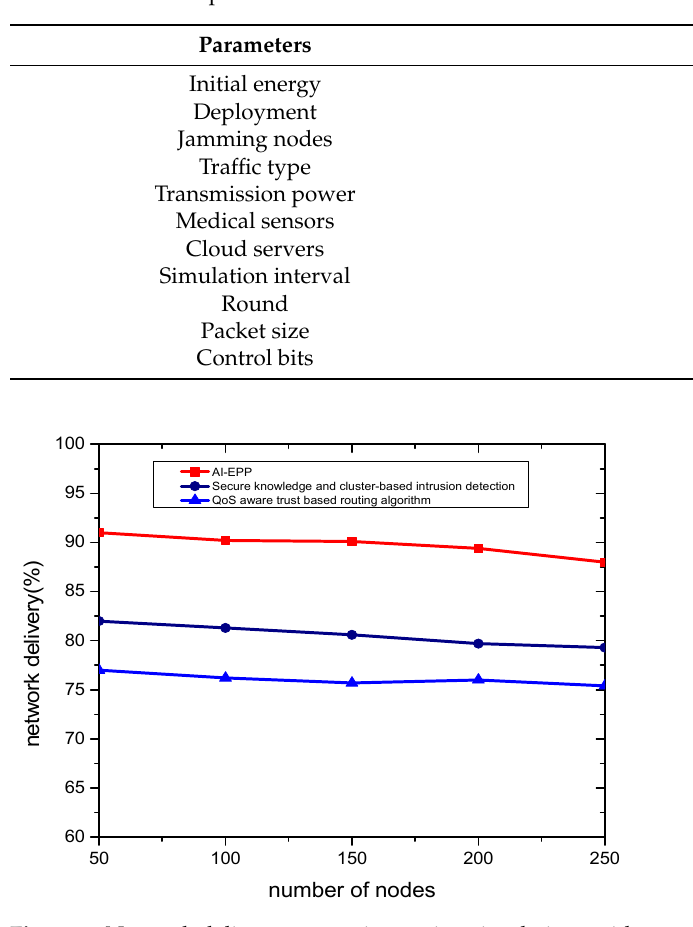
Figure 4. Network delivery comparison using simulations with varying data rates.